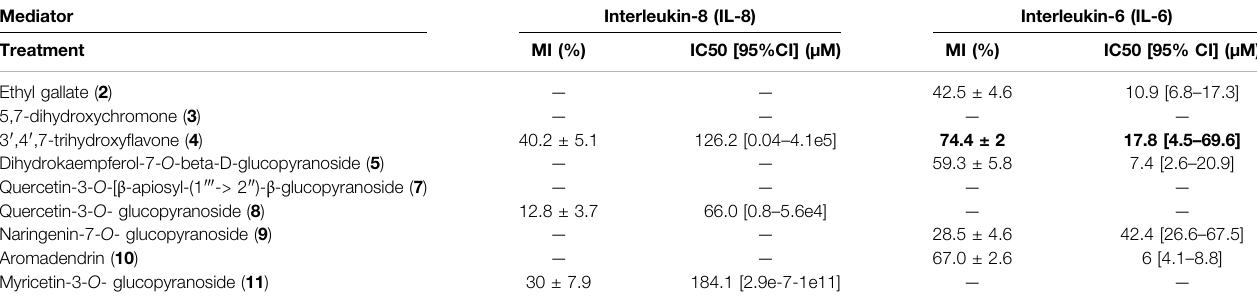
MI, maximum inhibition, IC 50 , half maximal inhibitory concentration. The values in bold represent: Single compounds with a strong inhibitory effect ( ≥